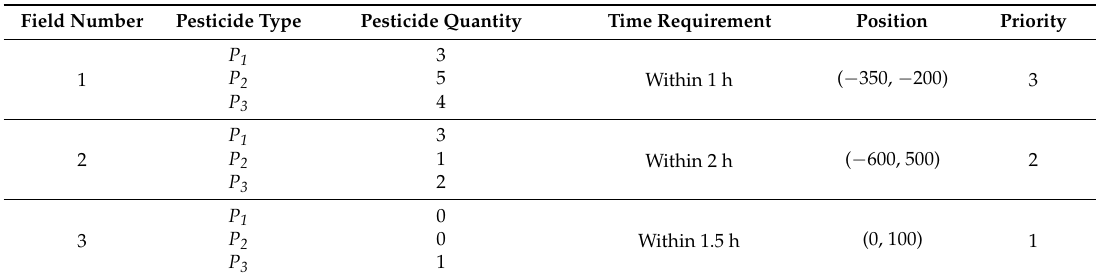
Table 3. Detail of fields and required resources.